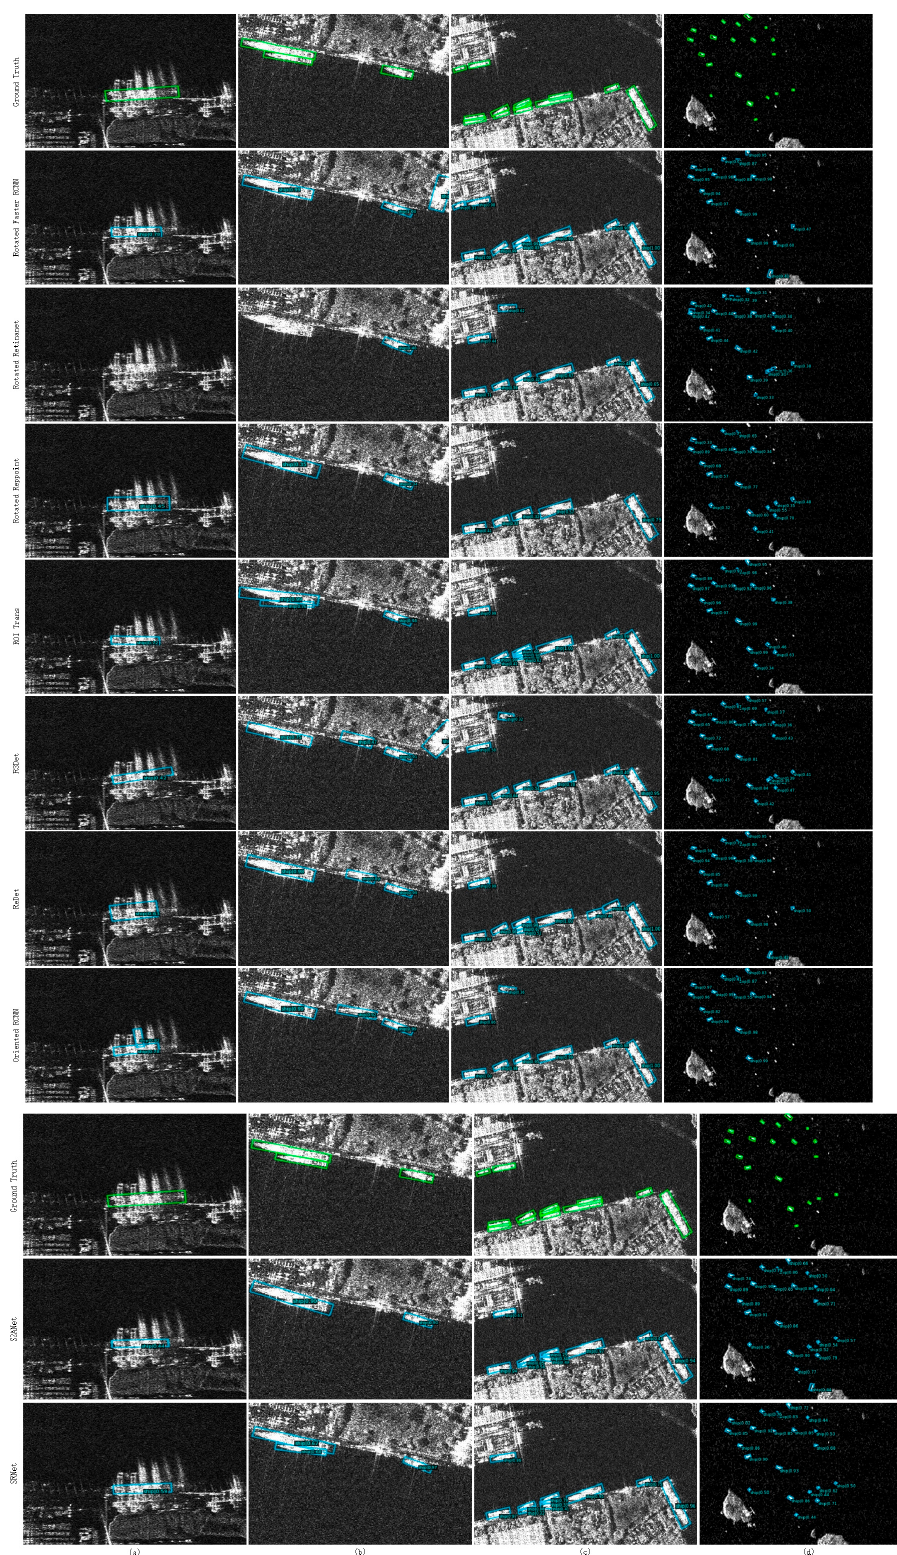
Figure 11. Four visualization illustration images of different comparison networks for rotated object detection on the SSDD dataset. ( a ) The scene of a single ship berthing in a dock. ( b ) The scene of parallel ships berthing in a dock. ( c ) The scene of multiple parallel ships berthing in a dock. ( d ) The scene of multiple ships sailing in the water region.